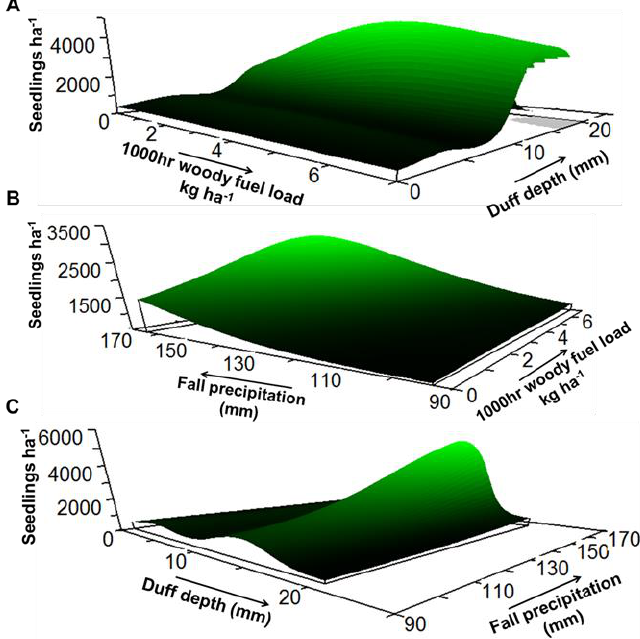
Figure 3. Ponderosa pine seedling density was impacted by 1000 h woody fuel load, which interacted with ( A ) duff depth, ( B ) fall precipitation, and by the interaction of ( C ) duff depth and fall precipitation. Grey areas indicate where the model lacked enough information to reliably predict the response. Note that y -axis ranges and orientation of x -axis may vary among panels.